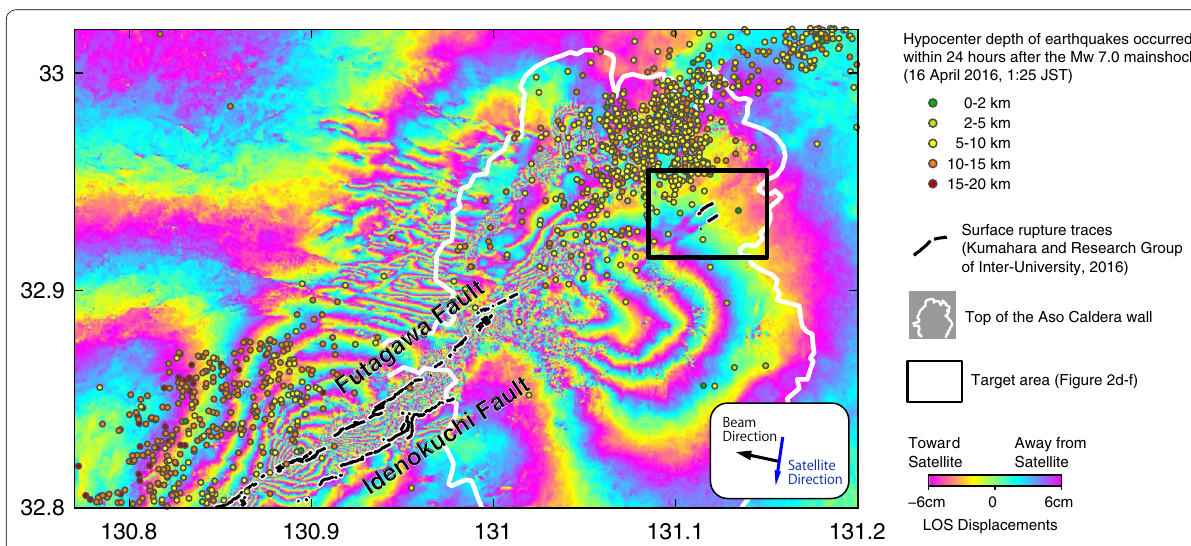
Fig. 1 Interferogram (Path 23), locations of the 24-h aftershocks of the Mw 7.0 mainshock (color-filled circles), and the target area (black